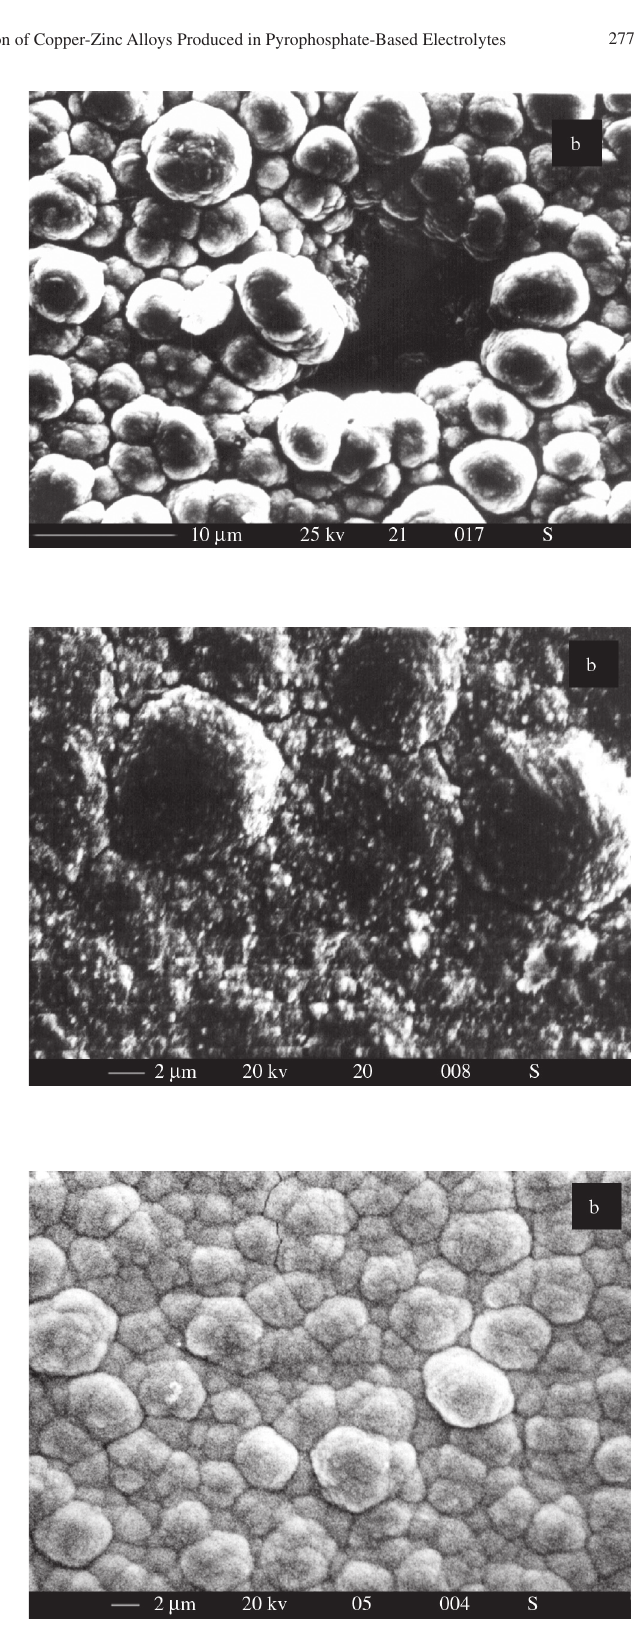
Figure 5. Morphology of coatings from Bath 5: a) 116 A/m 2 ; b) 154 A/m 2 .